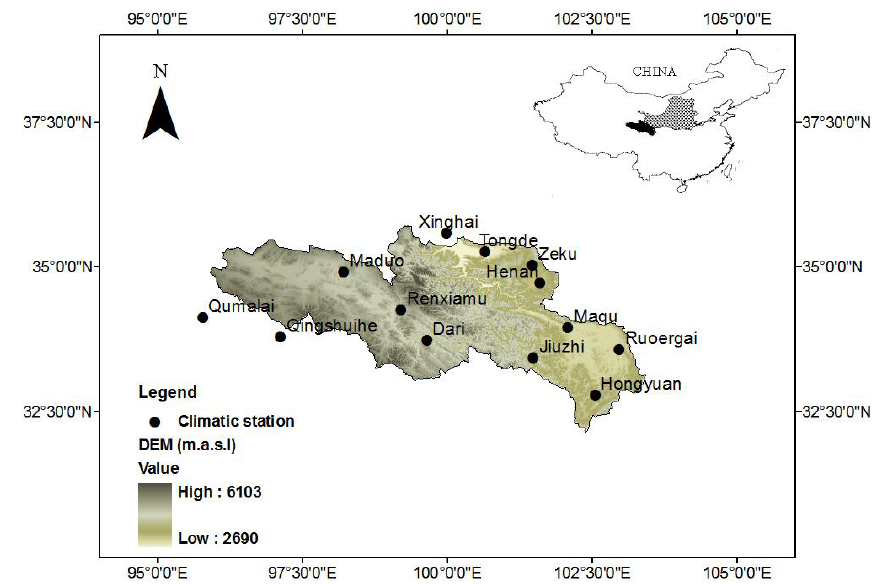
Fig. 1. Map of the study area showing the locations (filled circle) of climatic stations. The smaller map in the upper right corner presents the location the Yellow River source region in China (black shaded area).